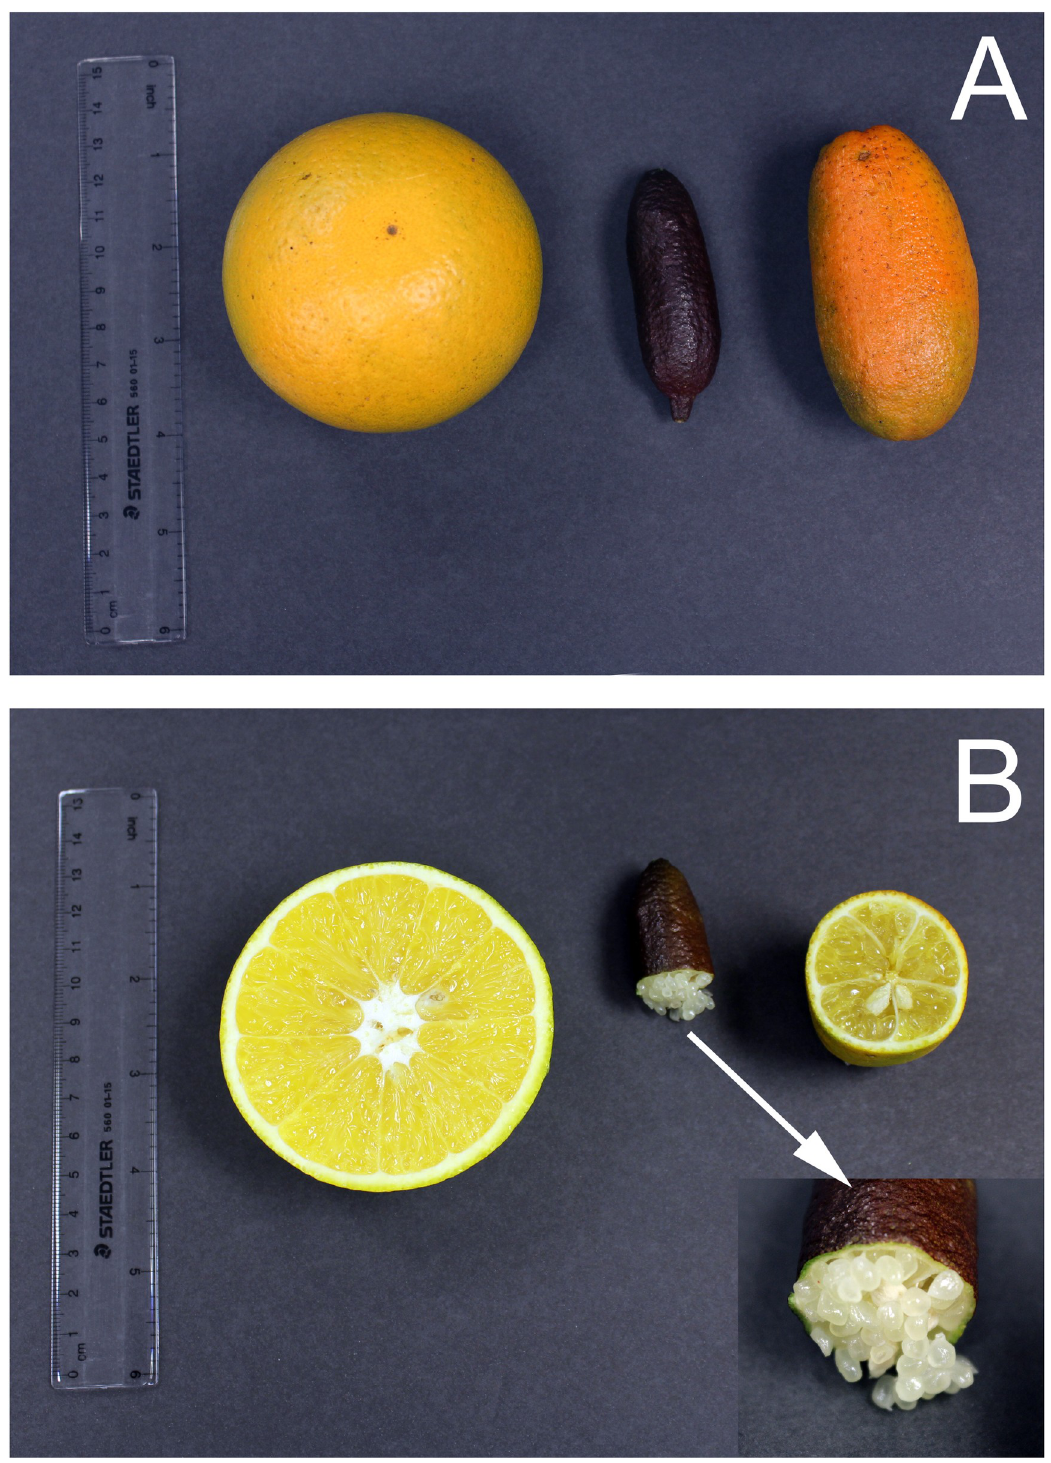
Fig 5. Fruit morphological characteristics of tetraploid finger lime and the diploid finger lime, external (A) and internal (B) characteristics. Left (OLL8, 2X), Middle (finger lime, 2X), right (OLL8+FL, 4X).